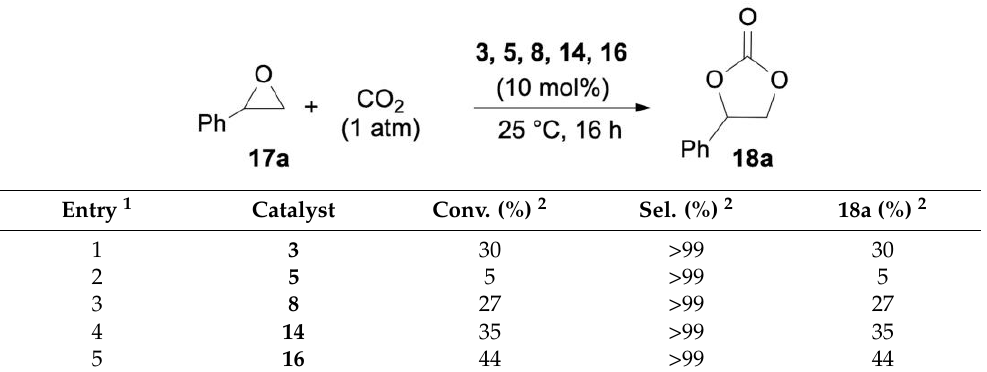
Table 2. Screening of organocatalyst 3 , 5 , 8 , 14 , and 16 activity.